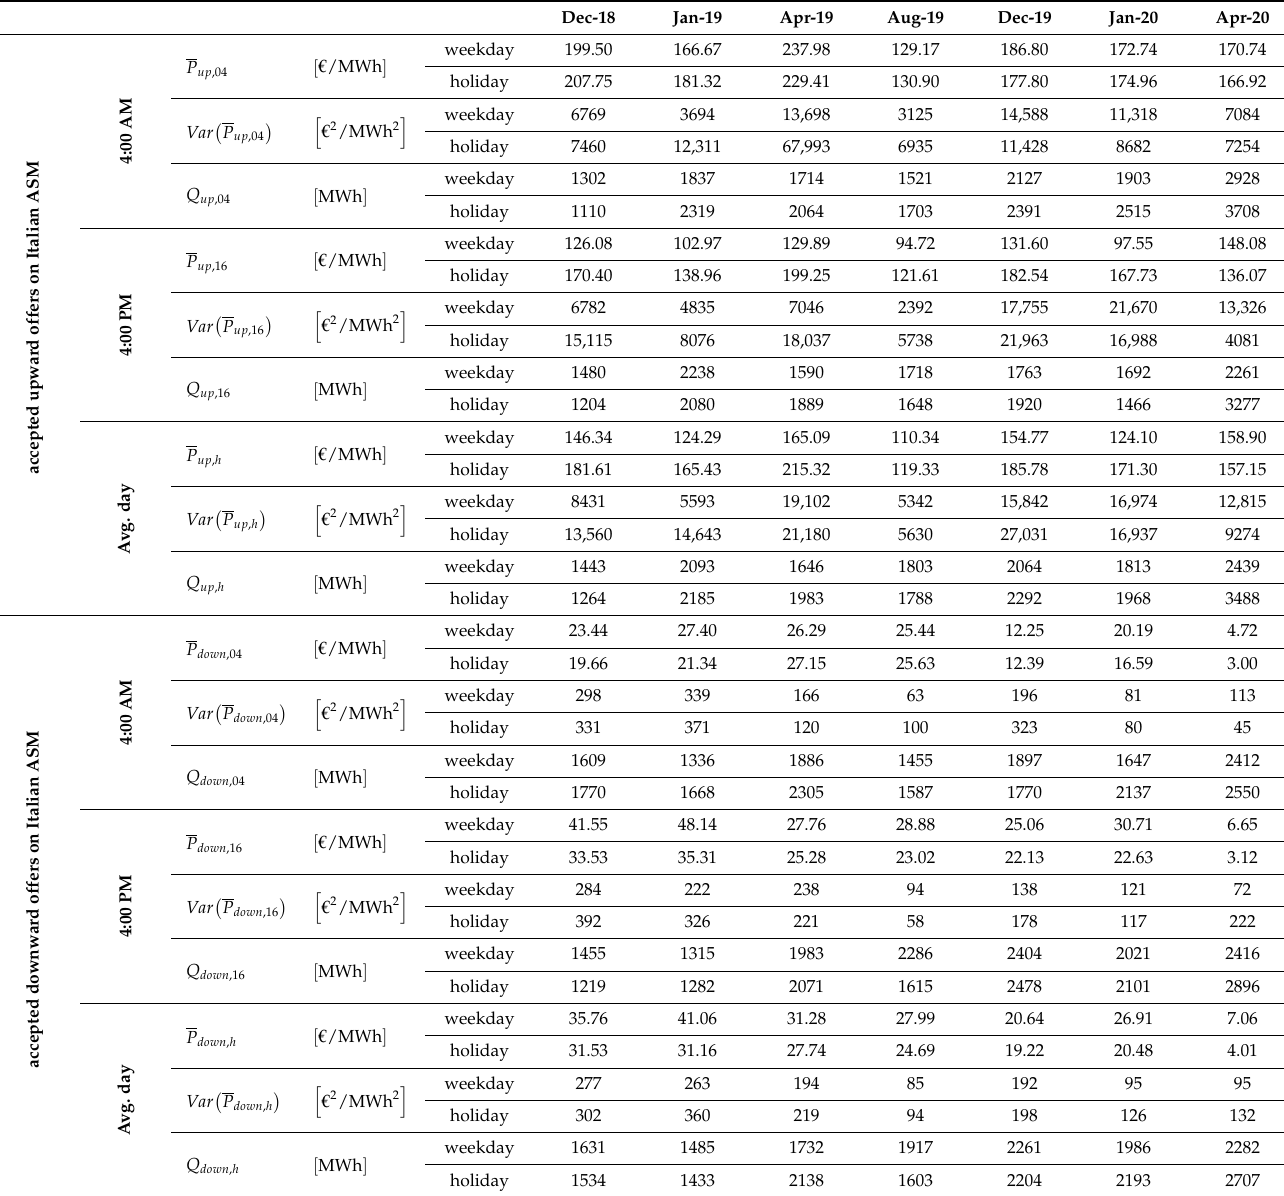
Table A2. Additional statistics on accepted hourly upward and downward bids on the Italian ASM for selected